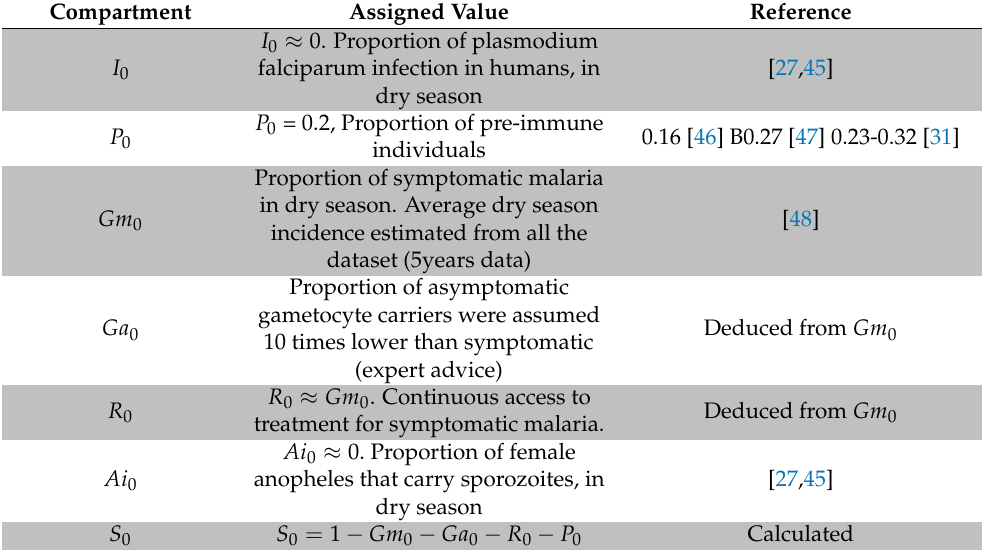
Table A2. Initial